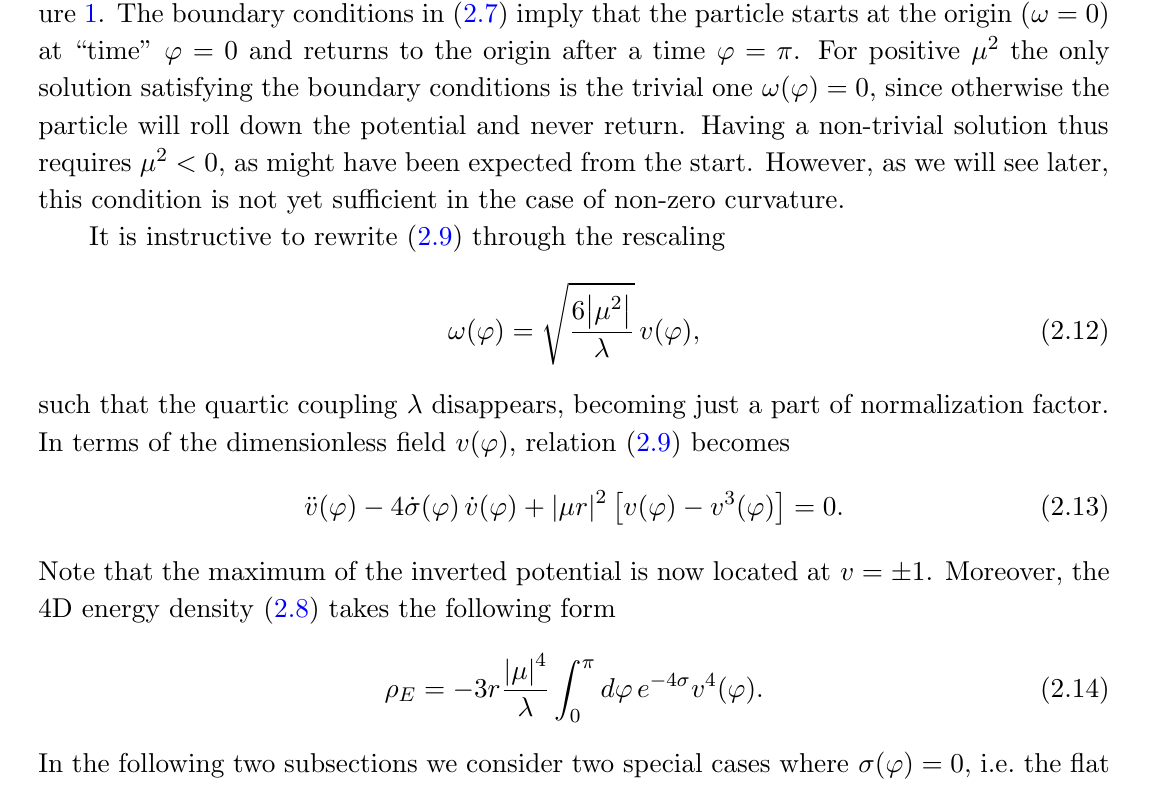
( ! ) for (cid:22) 2 > 0 (left) and (cid:22) 2 < 0 V